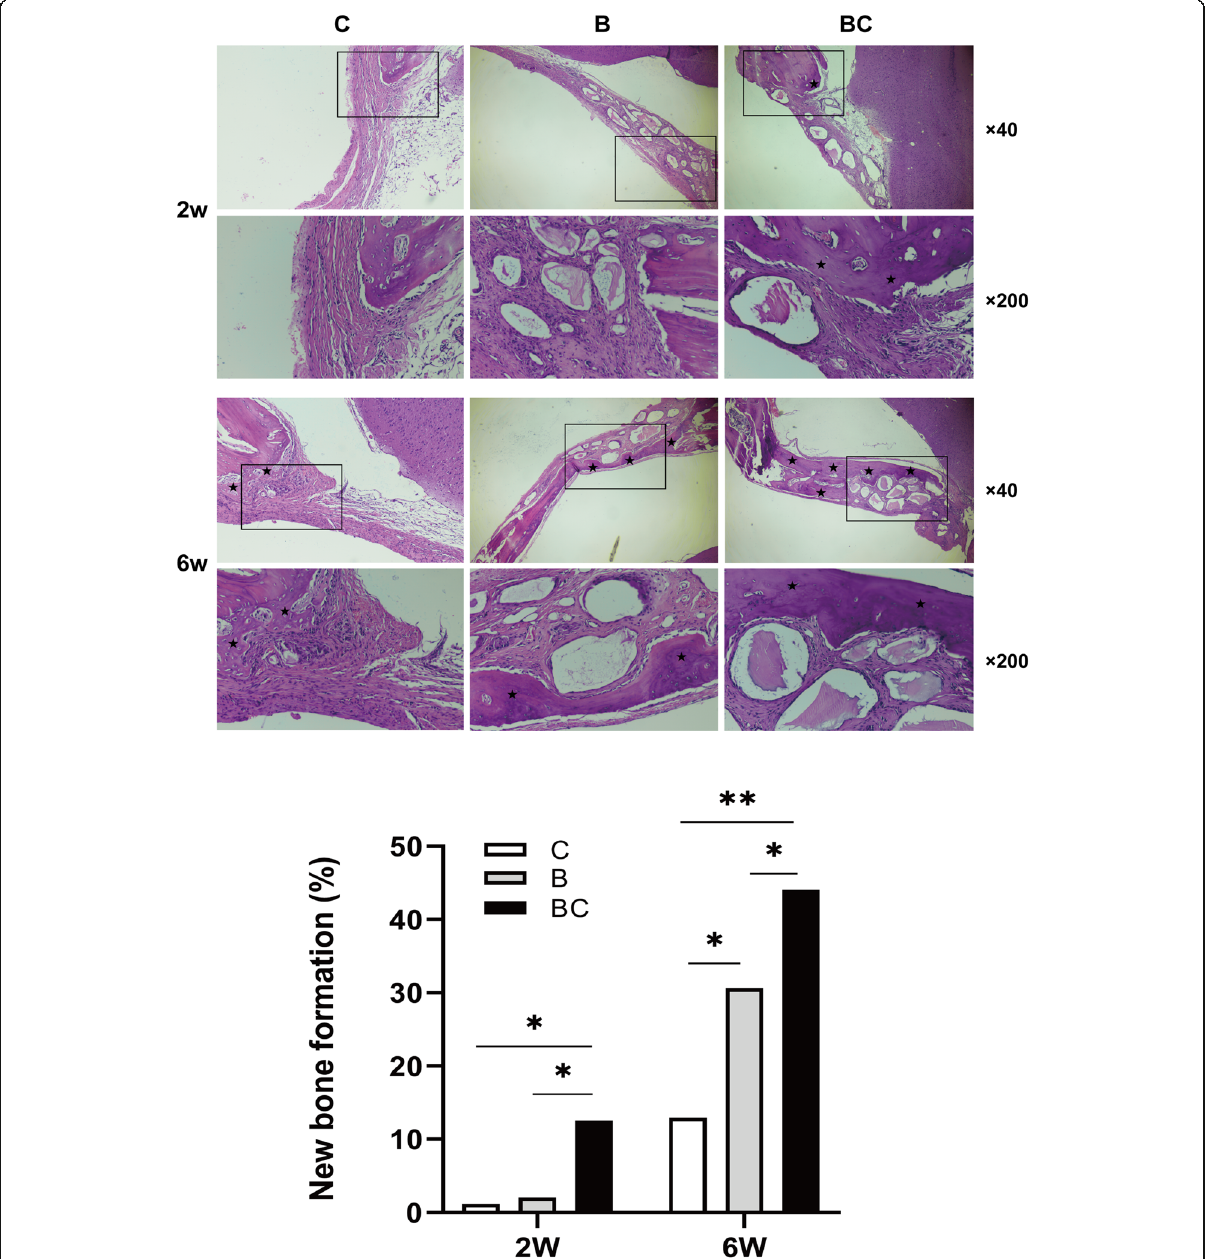
Fig. 4 HE staining analysis of the bone regeneration of critical-sized rat cranial defects. At 2 weeks, loose fibro-collagenous stroma and irregularly arranged cells could be seen at the edge of defect area in groups B and C, while new bone formation could be observed in group BC, which was limited to the area of the defect margin. At 6 weeks, only a small amount of new bone could be seen in group C; in group B, obvious new bone formation was seen, extending along the edge of the bone graft material; in group BC, a large amount of new bone formation was seen, extending from the old bone defect to the center of the bone defect, surrounding bone graft material. Group C, unfilled defect for control; group B, bone collagen alone; group BC, CGF-e + bone collagen. The histological images were photographed under a light microscope at ×40 and ×200 magnifications. (Black asterisk: new bone tissue) Quantitative analysis showed that the area of new bone formation (NBF) of the BC group was significantly higher than C and B groups. * p < 0.05; ** p <